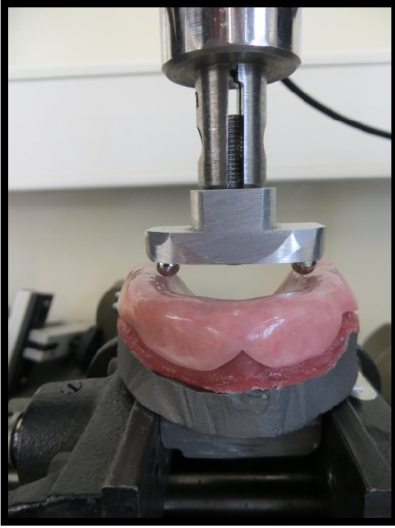
Figure 7. Model with a higher alveolar ridge placed on the test machine (TIRA test 2705 ® ) with a special indenter comprising two spherical steel beads.